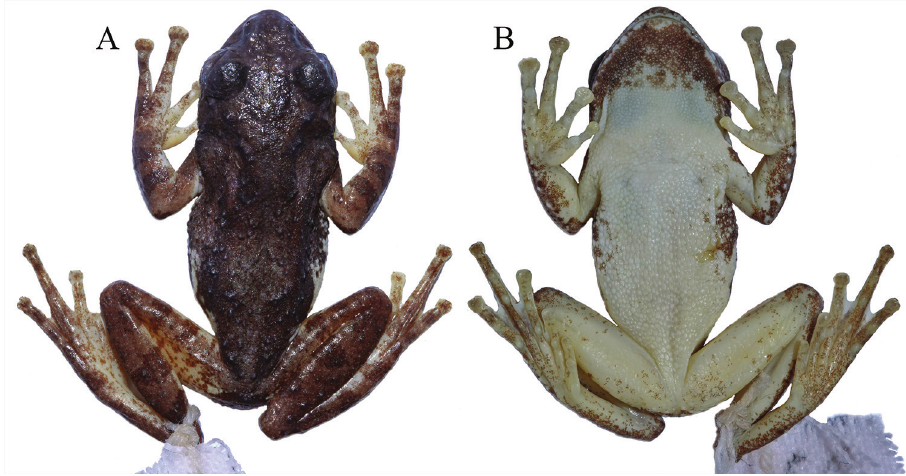
Figure 4. Dorsal A and ventral B views of the holotype of Kurixalus lenquanensis sp. n. in preservative.